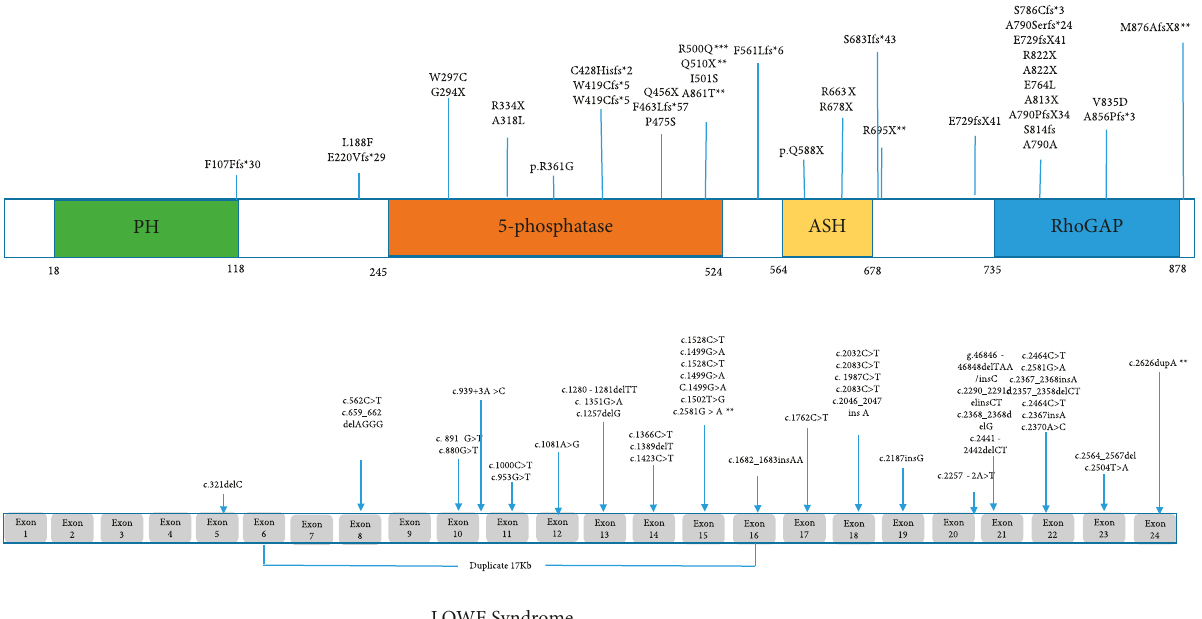
Figure 1: Exon structure of the OCRL gene with geometric shapes indicating relative positions of different types of mutations in Lowe syndrome.